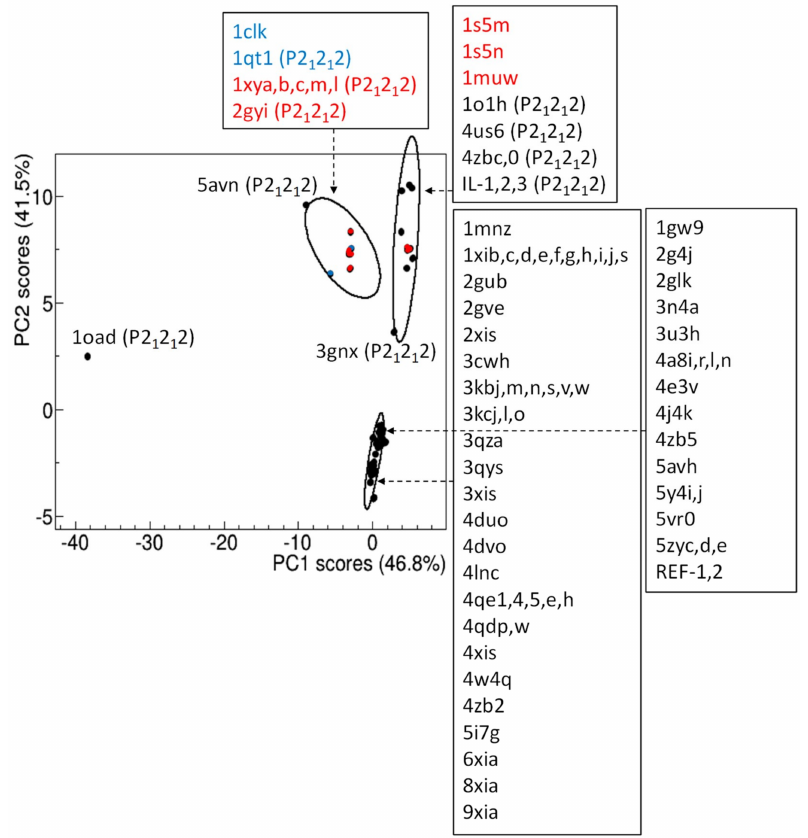
Figure 3. Comparison of experimental structural models of glucose isomerase by principal component analysis applied on crystal cell parameters. Score plot of the first two principal components, where representative points are clustered according to a hierarchic clustering. 85% confidence level ellipses are shown and PDB codes associated to representative points are reported. Space group are indicated if they are P2 1 2 1 2; in the other cases the space group is I222. The percentage of the total data variance explained by each principal component is shown on the axes. Data points and PDB codes corresponding to GI from organisms di ff erent from S. rubiginosus are colored in red ( S. olivochromogenes ) and in blue ( S. diastaticus